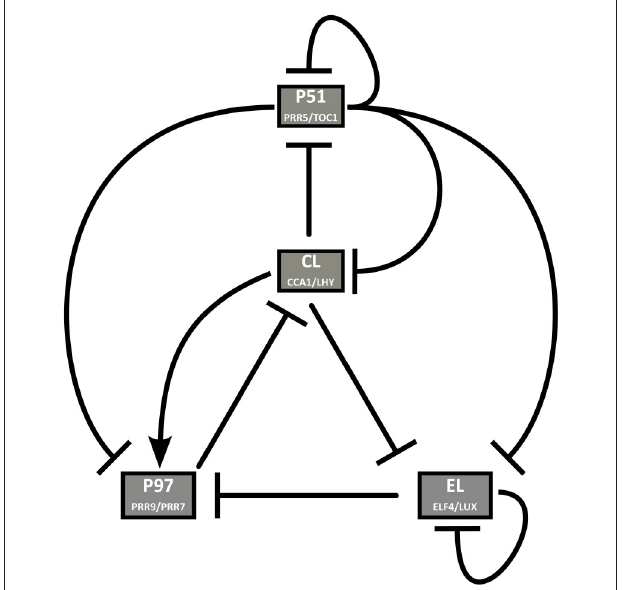
FIGURE 1 | Clock model structure. CL represents the dawn genes CCA1 and LHY , P97 represents the morning genes PRR9 and PRR7 , P51 represents the evening genes PRR5 and TOC1 , and EL represents ELF4 and LUX